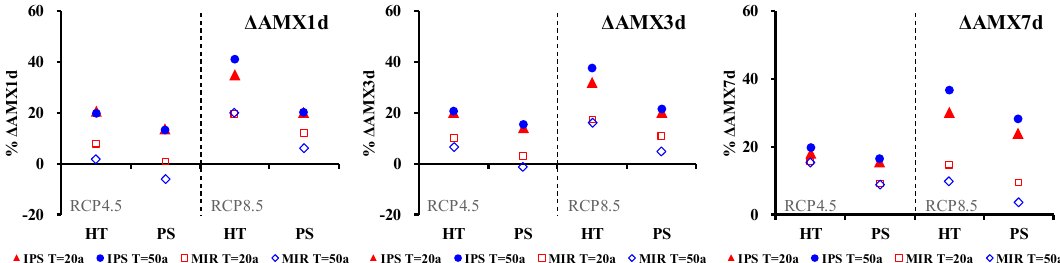
Figure 9. The projected changes of average AMX n d- T yr ( n = 1, 3, 7; T = 20a, 50a) of Huatan (HT) and the Pingshan (PS) with respect to the reference period (1961 to 1990) derived from the projections of RCP4.5 and RCP 8.5 climate scenarios of IPSL-CM5A-LR and MIROC-ESM-CHEM.